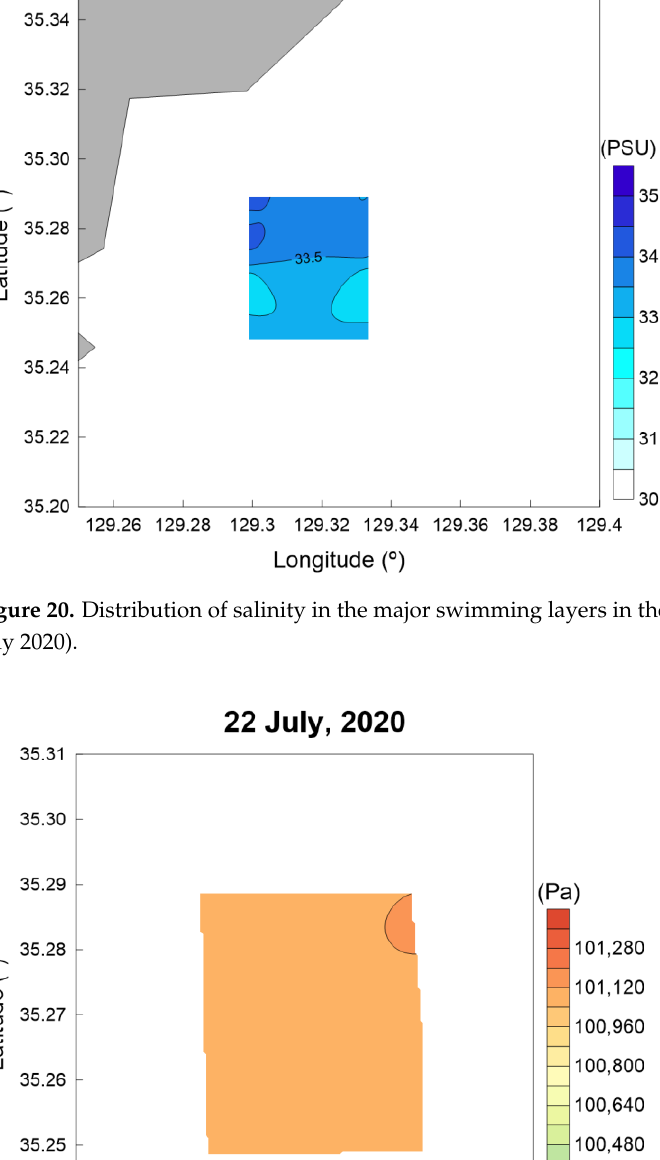
Figure 19. Distribution of temperature in the major swimming layers in the Gijang coastal waters sea (22 July, 2020).